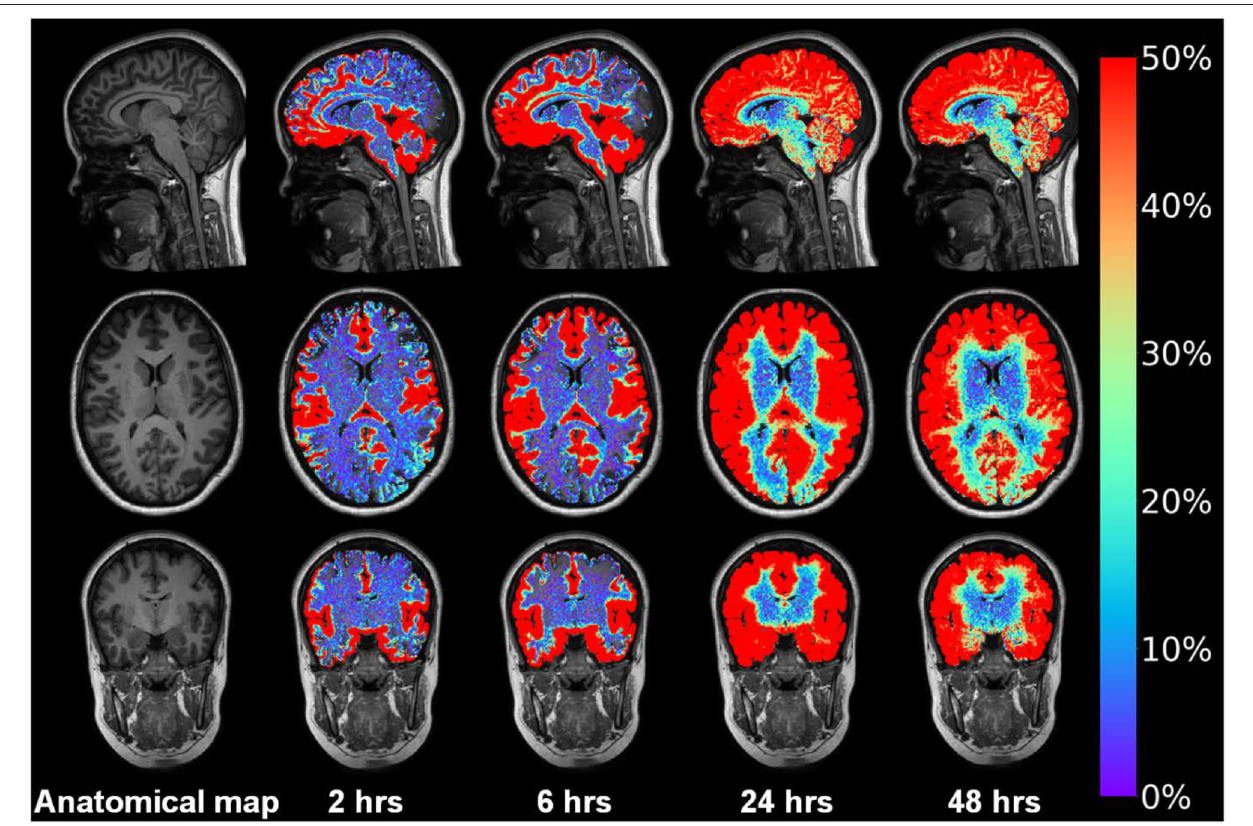
FIGURE 12 | Intrathecal contrast-enhanced MRI in one subject with IIH provides evidence for a glymphatic system in patients with IIH. Intrathecal injection of the MRI contrast agent gadobutrol (Gadovist tm , Bayer Pharma AG, Berlin, Germany) in a dose 0.5 mmol, serves as a CSF tracer molecule. Gadobutrol has a molecular size of about 604 Da and is highly hydrophilic, making it suitable for transport within the CSF. After arriving to the subarachnoid CSF, the tracer is contained outside the blood vessels since it does not pass the BBB. Using FreeSurfer, tracer in CSF spaces is subtracted, only showing enrichment of tracer in brain parenchyma over time in this IIH patient responding to shunt surgery. The tracer enriched in the interhemispheric fissure and Sylvian fissure and medial temporal where the large vessels resides anterior middle cerebral and posterior cerebral arteries, respectively. Moreover, the tracer enriched in a centripetal fashion; at 24h the entire brain had enriched with tracer that lasted at 48h. In vivo evidence for impaired glymphatic function in IIH has been given before ( Eide et al., 2021b). Illustration: Lars Magnus Valnes, Department of neurosurgery, Oslo university hospital, Oslo,